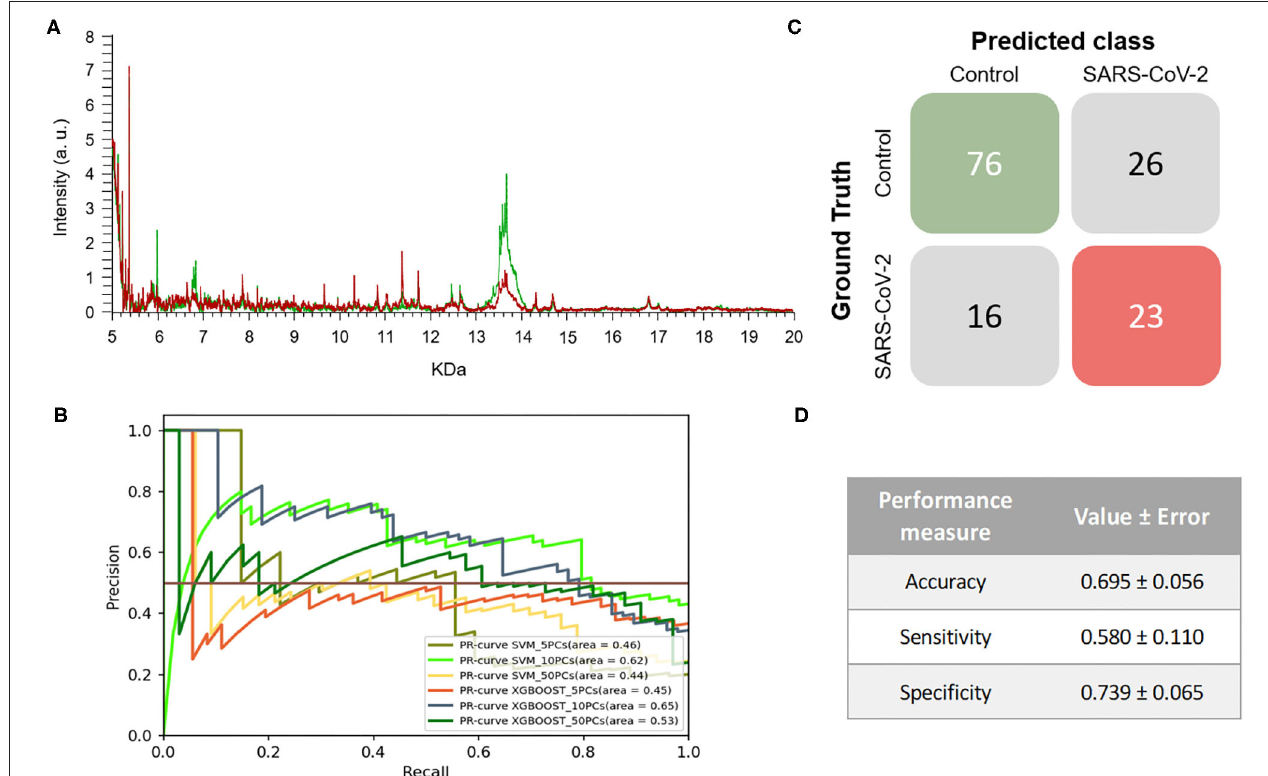
FIGURE 1 | Results of the first experiment. (A) Representative mass spectra of NP samples for SARS-CoV-2: positive (red) and negative (green). (B) Precision-recall curve from the different models. (C) Average confusion matrix and (D) average performance metrics including the standard deviation (note that the test was performed 20 times selecting random different samples for each iteration) of the best model (SVM + 10PCs cross-validation K = 10).